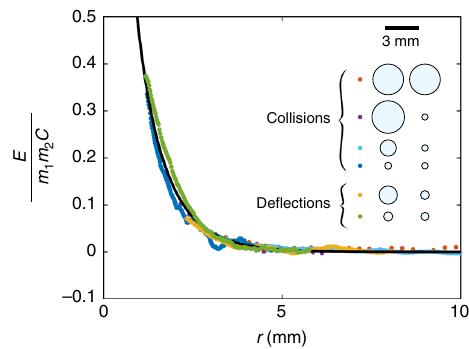
Fig. 2 Experimental measurement of the Cheerios potential. The experimental (nondimensional) potential E ð r Þ = ð Cm 1 m 2 Þ is extracted from the dynamics of a pair of particles. Each color corresponds to a different experiment, with particles radii and mass ratio systematically varied. ð r = a Þ , plotted as a 0